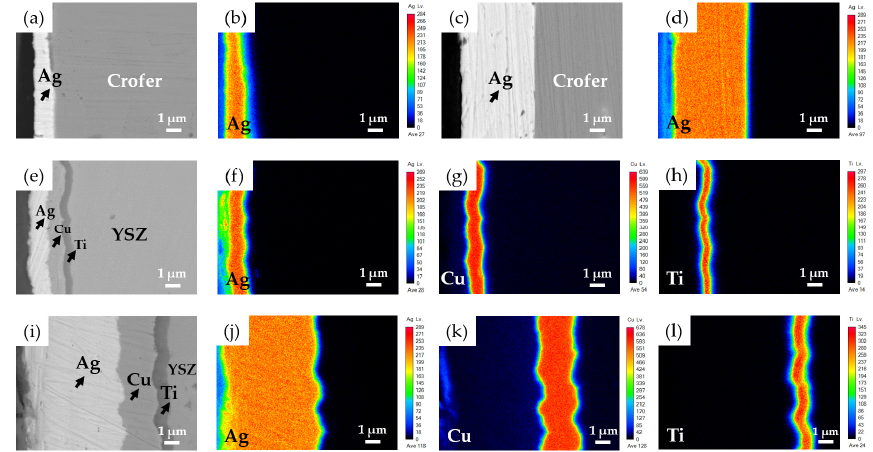
Figure 1. Cross-sectional BEIs and element mappings of the Crofer and YSZ substrates after sputtering: ( a ) Ag(1.5 μ )/Crofer, ( b ) Ag mapping in ( a ), ( c ) Ag(5 μ )/Crofer, ( d ) Ag mapping in ( c ), ( e ) Ag(1.5 μ )/Cu(1 μ )/Ti(0.5 μ )/YSZ, ( f – h ) Ag, Cu, and Ti mappings in ( e ), ( i ) Ag(5 μ )/Cu(3 μ )/ Ti(1 μ )/YSZ, and ( j – l ) Ag, Cu, and Ti mappings in ( i ).